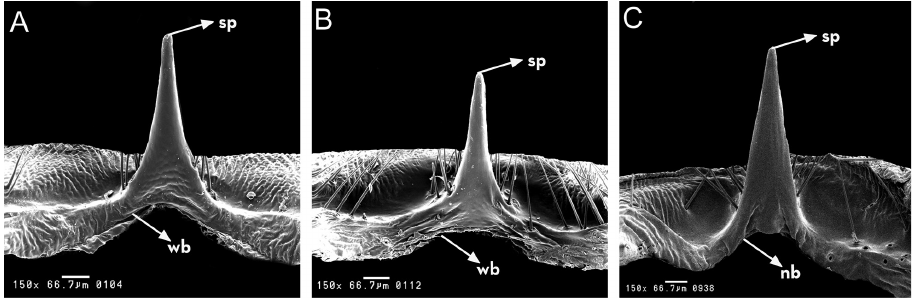
Figure 8. Median process of the pygophore of R. marabaensis sp. n. ( A ), R. prolixus ( B ), R. robustus ( C ). gp: gross point: nb: narrow triangular base; sp: slender point; wb: wide triangular base.